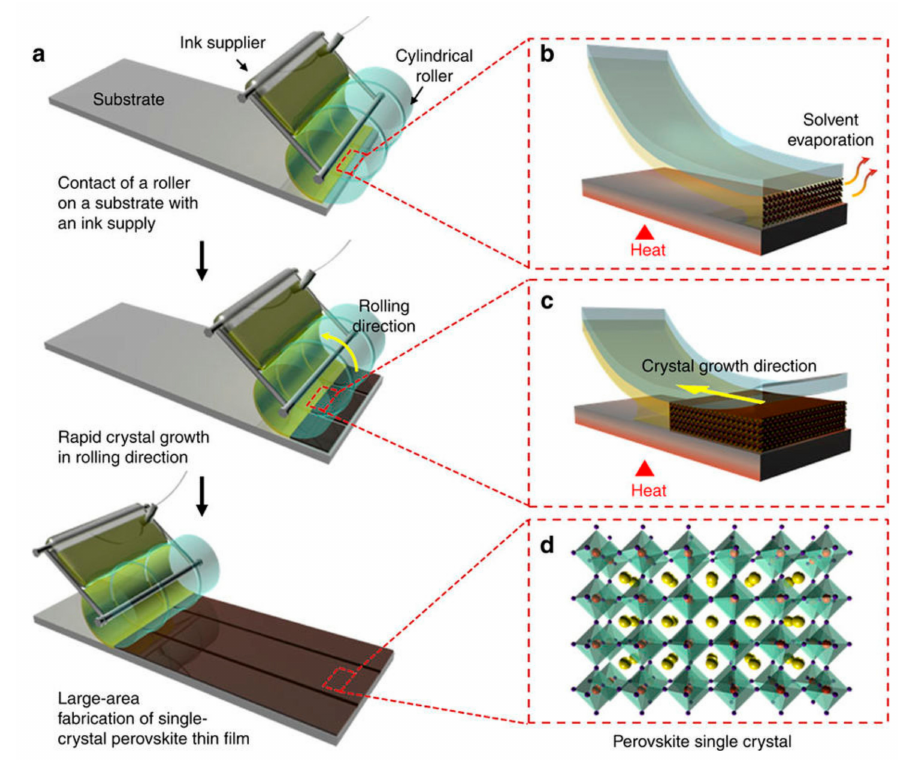
Figure 13. Procedure of single-crystal perovskite thin films using geometrically confined lateral crystal growth with a rolling module. ( a ) General process of the film fabrication. ( b ) Schematic of solvent evaporation by thermal heating. ( c ) Schematic of crystal growth direction. ( d ) The perovskite single crystal structure. Reproduced with permission from Ref.